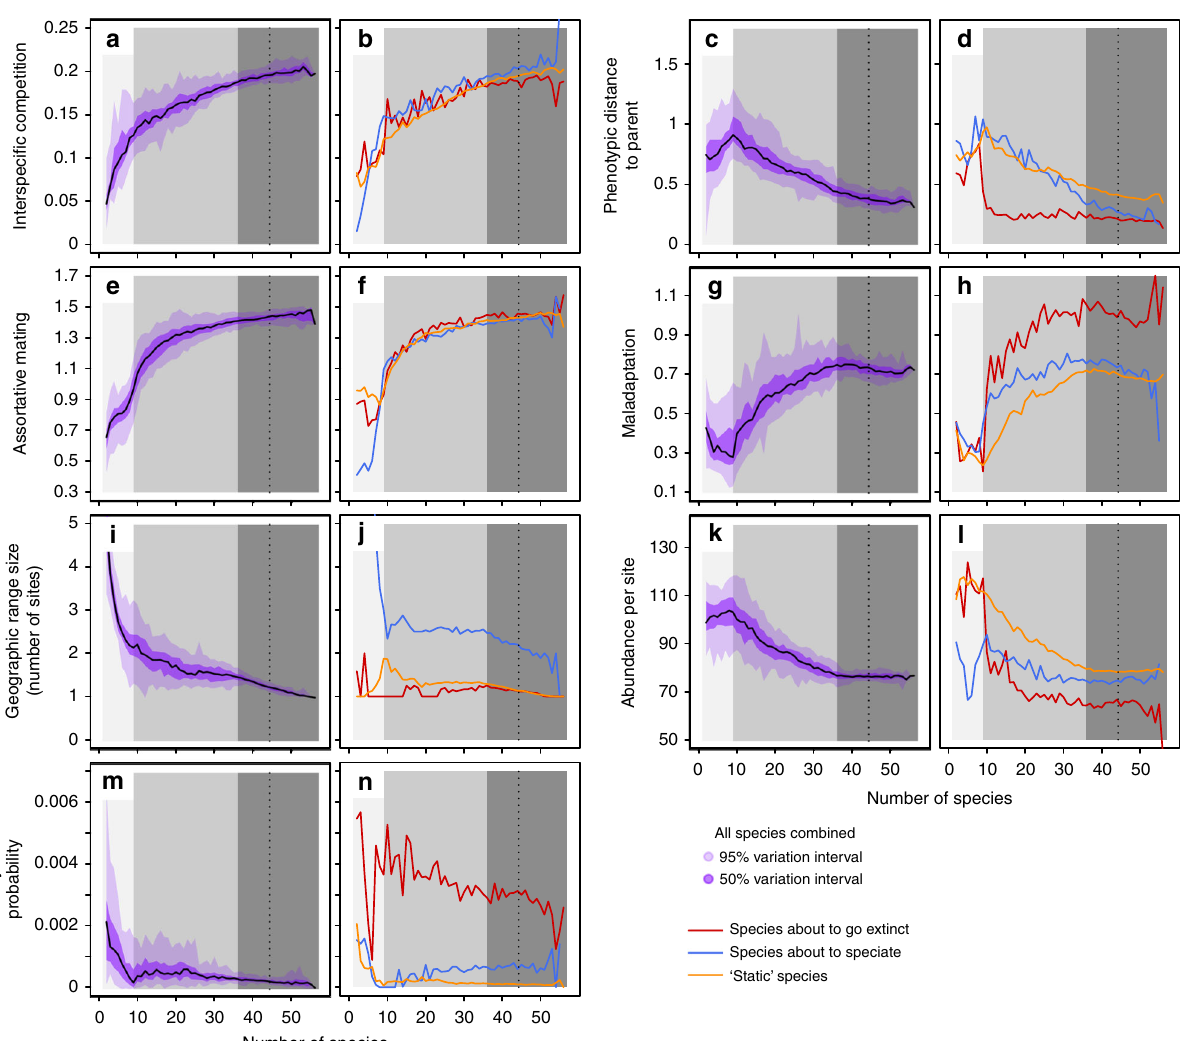
Fig. 3 Diversity dependence of key ecological and genetic variables. Simulations were replicated 50 times with default parameter values (Supplementary Table 1). For each variable (see Methods, section “ Numerical simulations ” for details about the computation of each variable), the left column ( a , c , e , g , i , k , m ) shows median values (black lines), 95% and 50% con fi dence intervals (purple areas), computed across all species (as in Fig. 1d – f); the right column ( b , d , f , h , j , l , n ) shows median values for species about to speciate (within the next 200 generations; blue), about to go extinct (within the next 200 generations; red), and for “ static ” species (neither speciation nor extinction within the next 2000 generations; orange). The three stages of diversi fi cation (1 – 3) are highlighted by gray shadings, as in Fig. 1. A sensitivity analysis of these results is reported in Supplementary Figs. 6